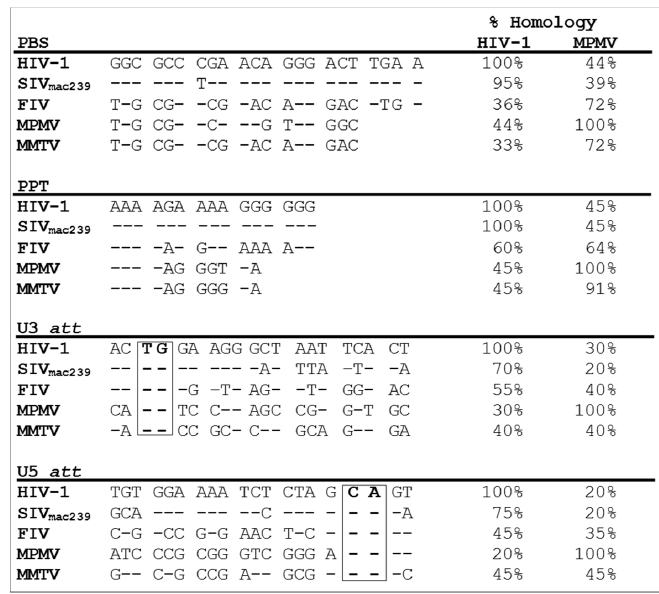
Figure 3. Comparison of the major cis ‐ acting sequences among different retroviruses required for the reverse transcription and integration steps of retroviral life cycle. The canonical TG and CA dinucleotides within the 3’ and 5’ attachment (att) sequences, respectively, are boxed. All sequences are compared to either that of HIV ‐ 1 or MPMV, where a “ ‐ “ represents homology, while differences are shown by the native nucleotide sequence. PBS: primer binding site; PPT: polypurine tract; U3 att: 3’ attachment site in the U3 region; U5 att: 5’ attachment site in the U5 region of the long terminal